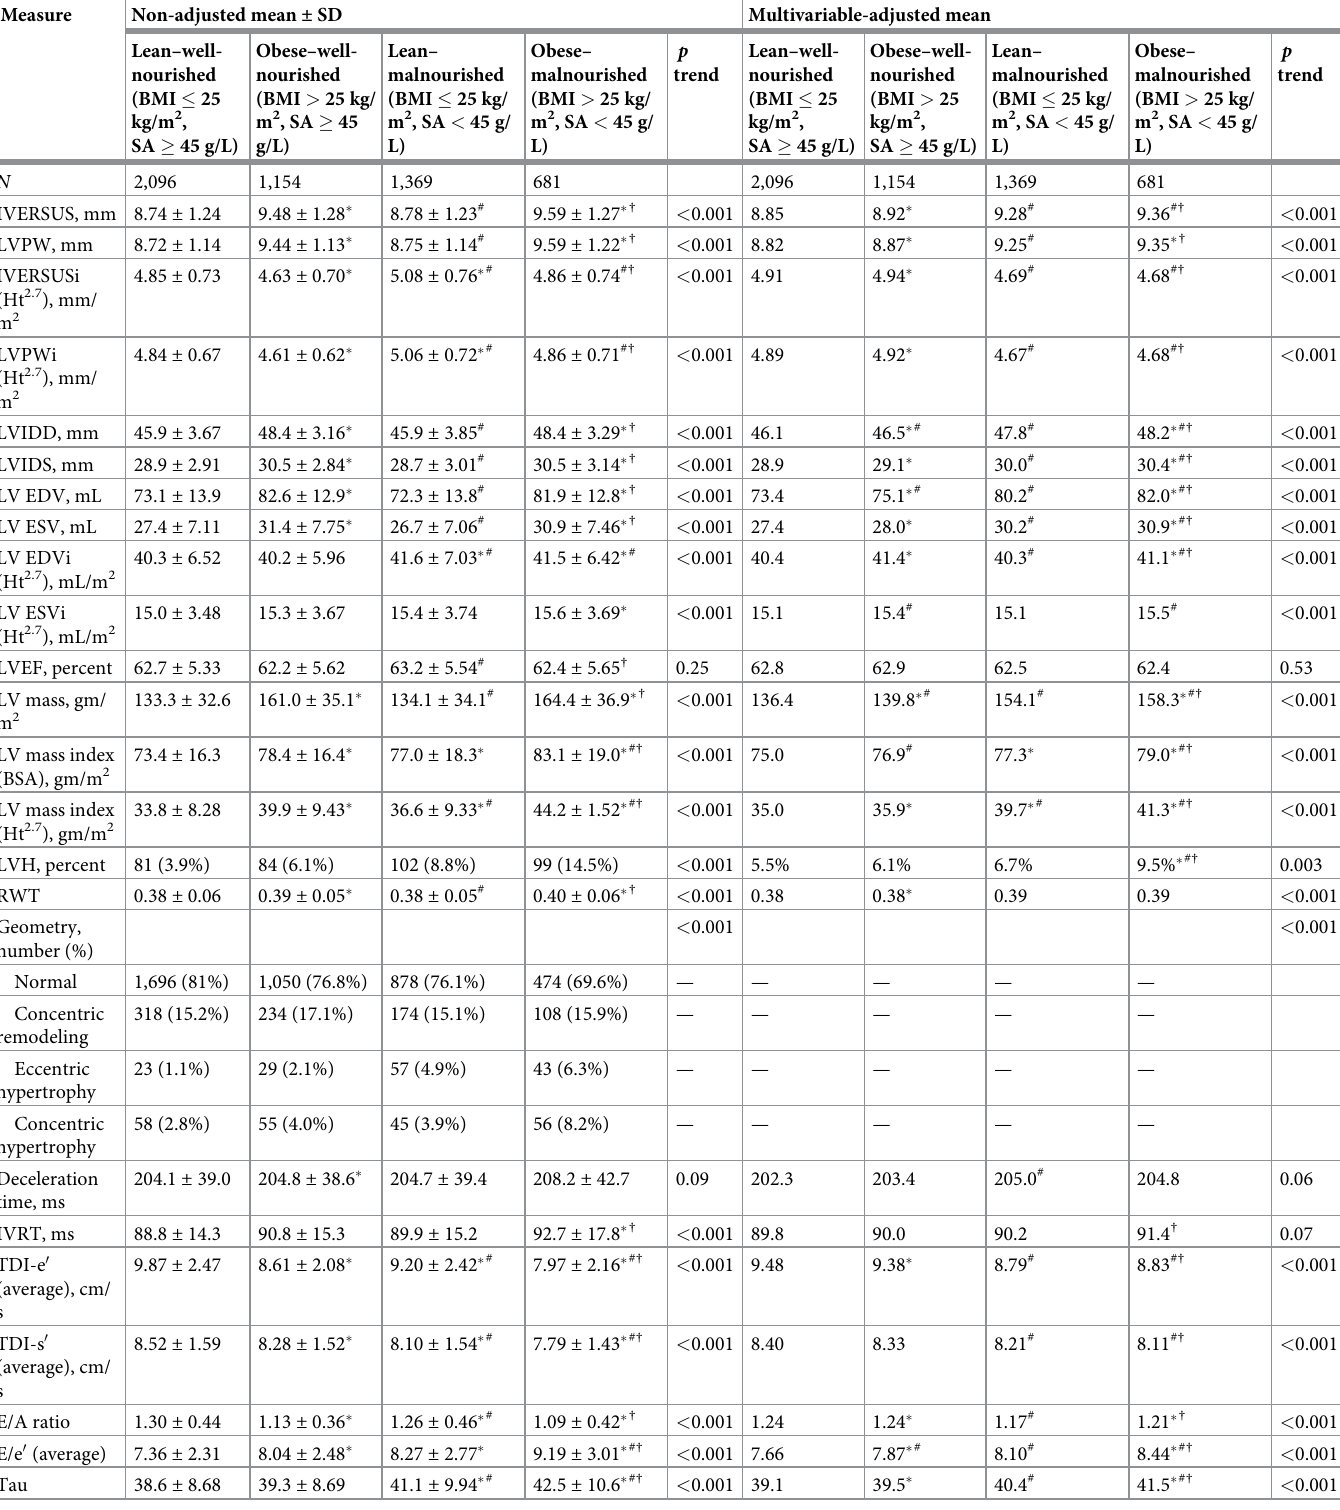
Table 2. Echocardiography information of study participants according to obesity and serum albumin categories. Measure Non-adjusted mean ±